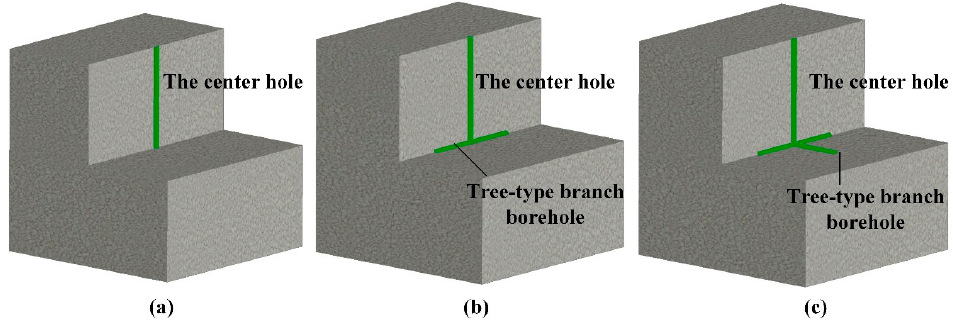
Figure 7. Different forms of tree-type branched borehole models: ( a ) zero-branched model; ( b ) two-branched model; and ( c ) four-branched model.